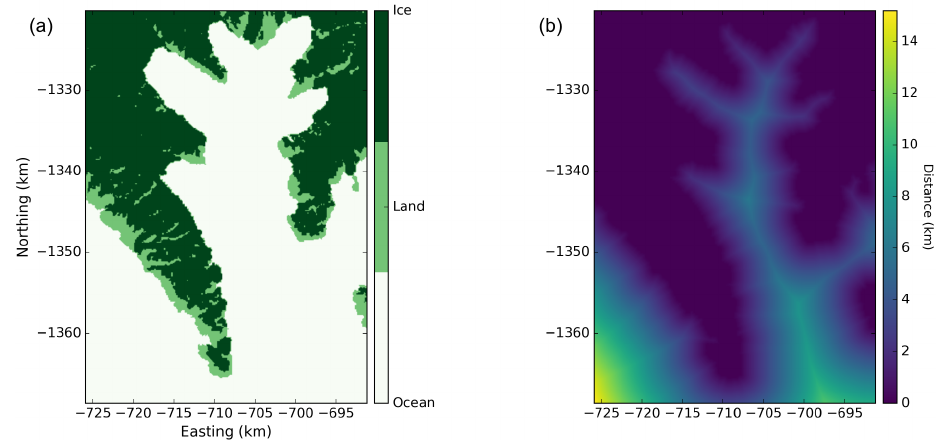
Figure 4. The area of interest close to Cape York illustrating (a) land classification taken from the GIMP land mask (Howat et al., 2014; Morlighem et al., 2014) and (b) the distance of ocean regions relative to land/ice